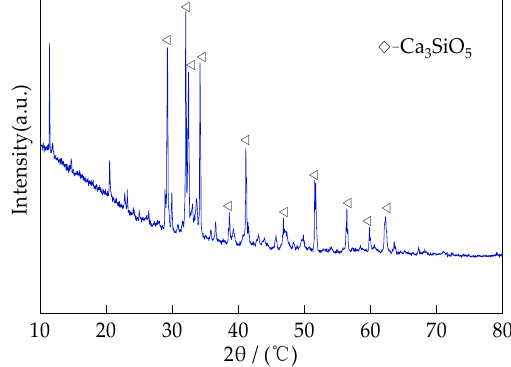
Figure 1. XRD diagram of cement. Table 2. Chemical composition of Cement.